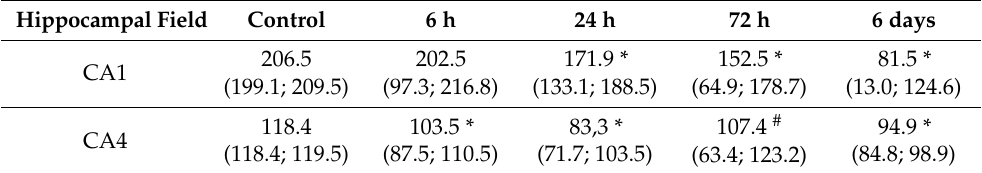
Table 2. Number of normal viable pyramidal neurons in fields CA1 and CA4 of the hippocampus at different periods after MCAO, per 1 mm of cell layer